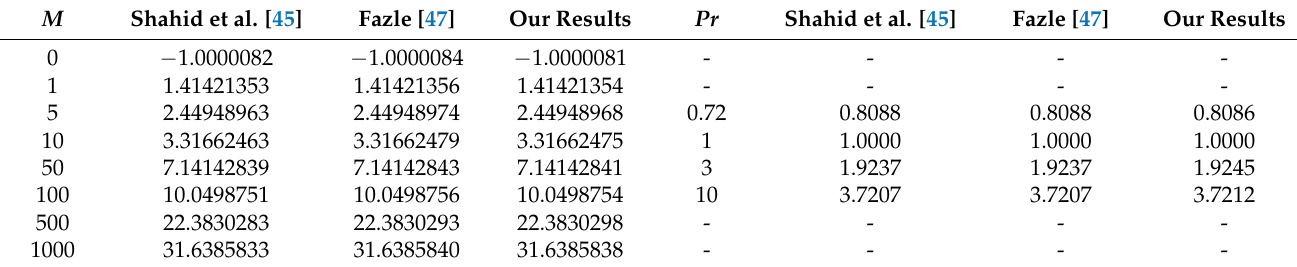
Table 2. Skin friction and Prandtl number comparison for various values of M and Pr .